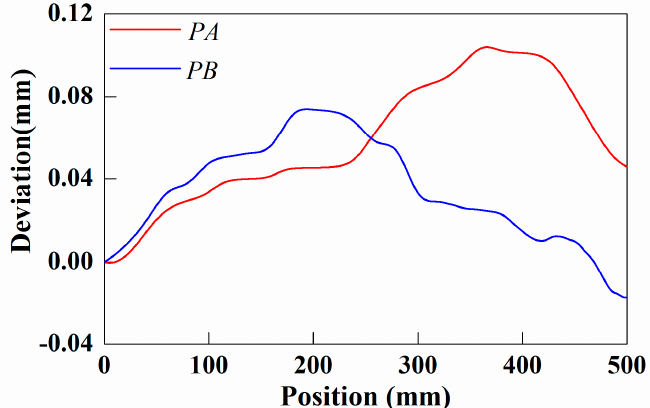
Figure 24. Known surface shape contours.